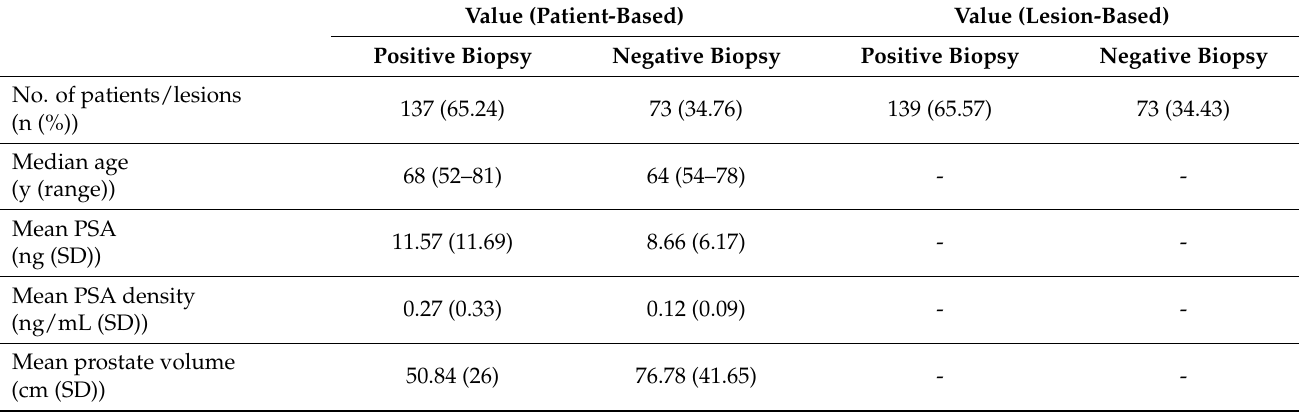
Table 1. Clinical details and biopsy results on per-patient and per-lesion bases. Value